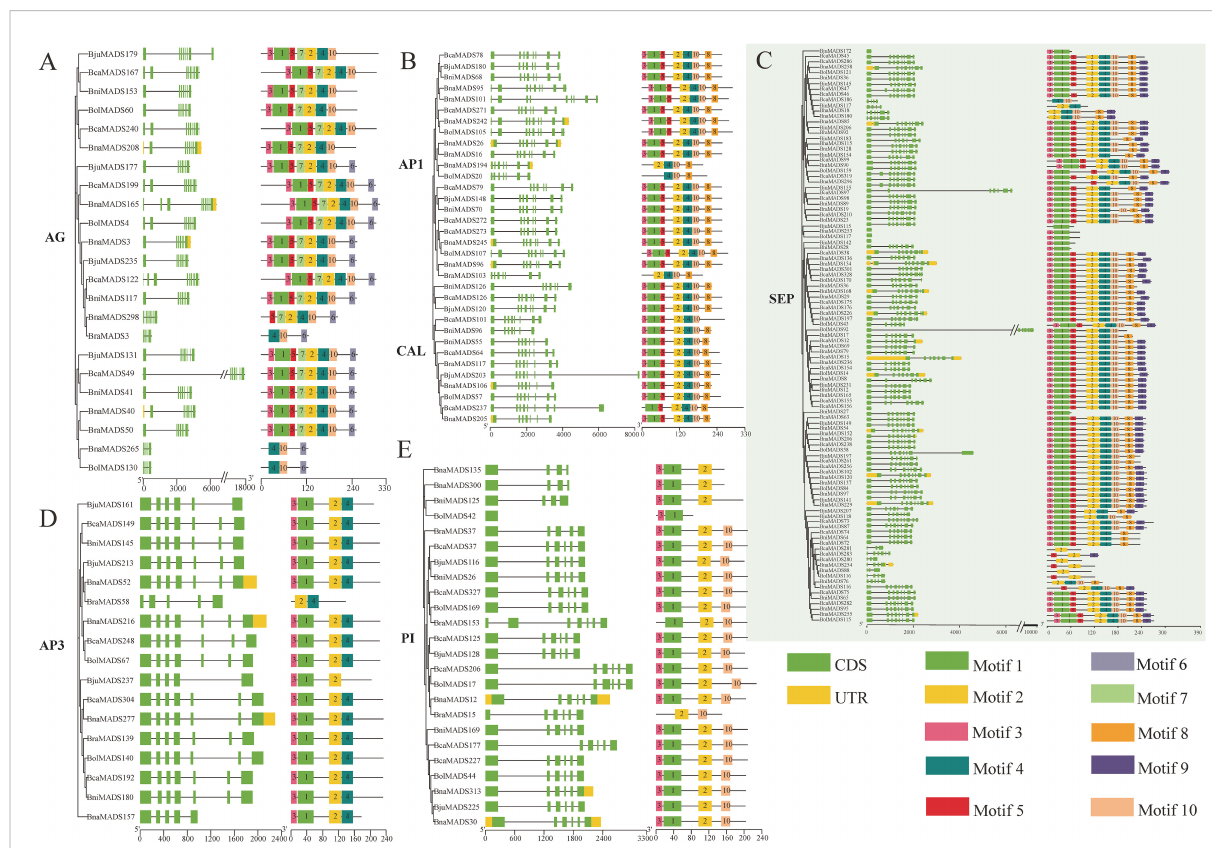
FIGURE 3 Gene structure and conserved motifs of six MIKC-type subclades [AG ( A ), AP1 and CAL ( B ), SEP ( C ), AP3 ( D ), and PI ( E )]. The green boxes, yellow boxes, and block lines represent the exons, UTR, and introns, respectively. Ten different colored boxes represent ten distinct